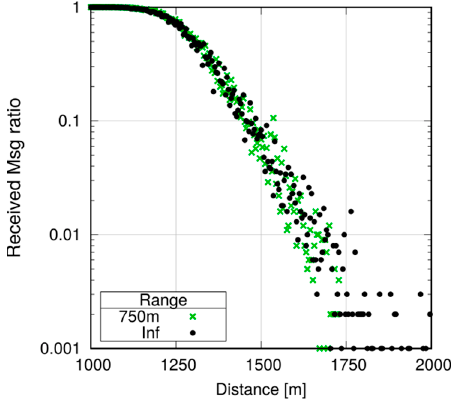
Figure 28. Reception probability in the multihop case, h = 500 m.